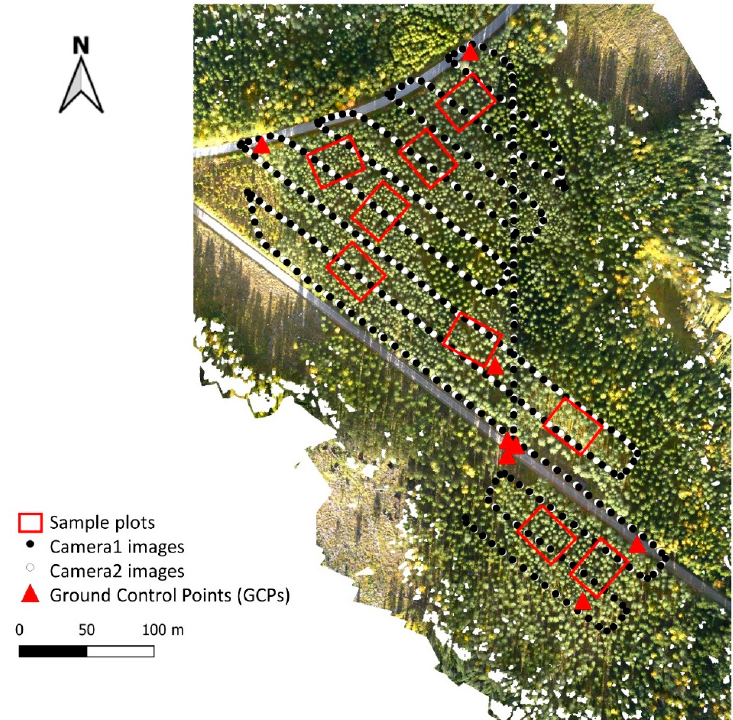
Figure 2. UAV flight lines as well as locations for the ground control points (GCPs) and sample plots are presented on top of an orthomosaic illustrating the forest structural variation in study site